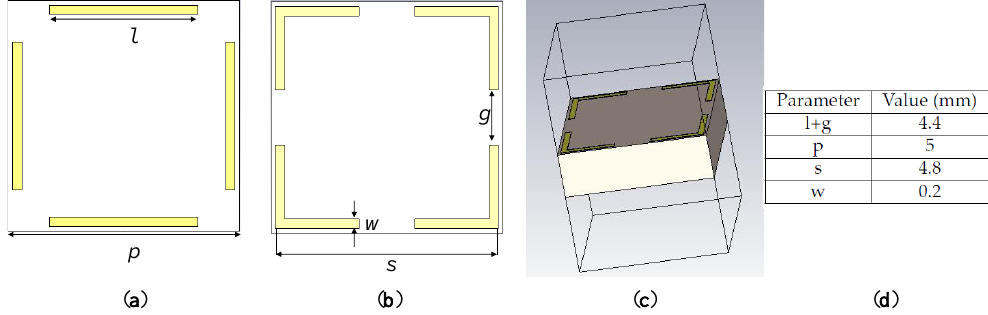
Figure 1. The configuration of the huygens’ metasurface, ( a ) front view, ( b ) back view, ( c ) simulation setup, and ( d ) the parameter values.